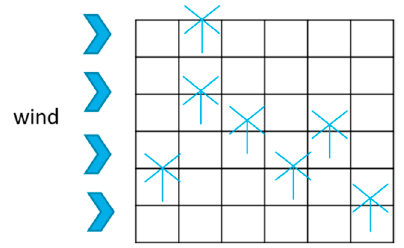
Figure 1. The example for random positioning of 7 turbines in 6 × 6 matrix. Random matrix generation: